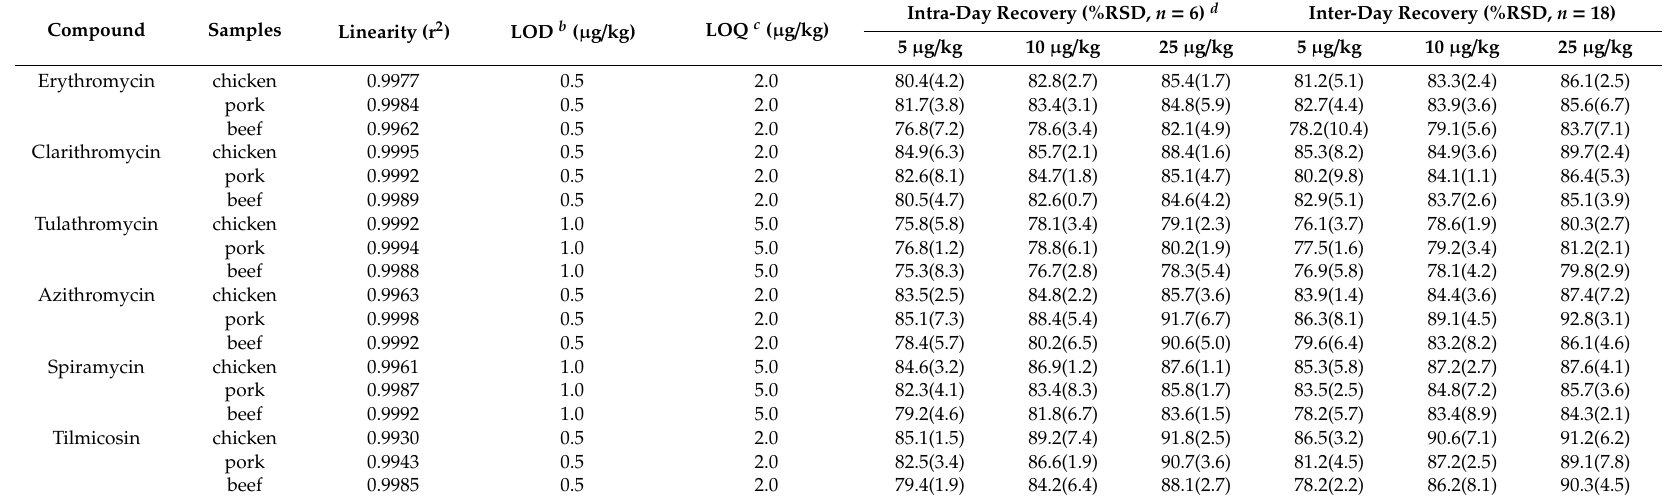
Table 2. Validation data for six macrolide antibiotics after molecularly imprinted polymer monolith microextraction (MIPMME) procedure in spiked animal muscle samples a